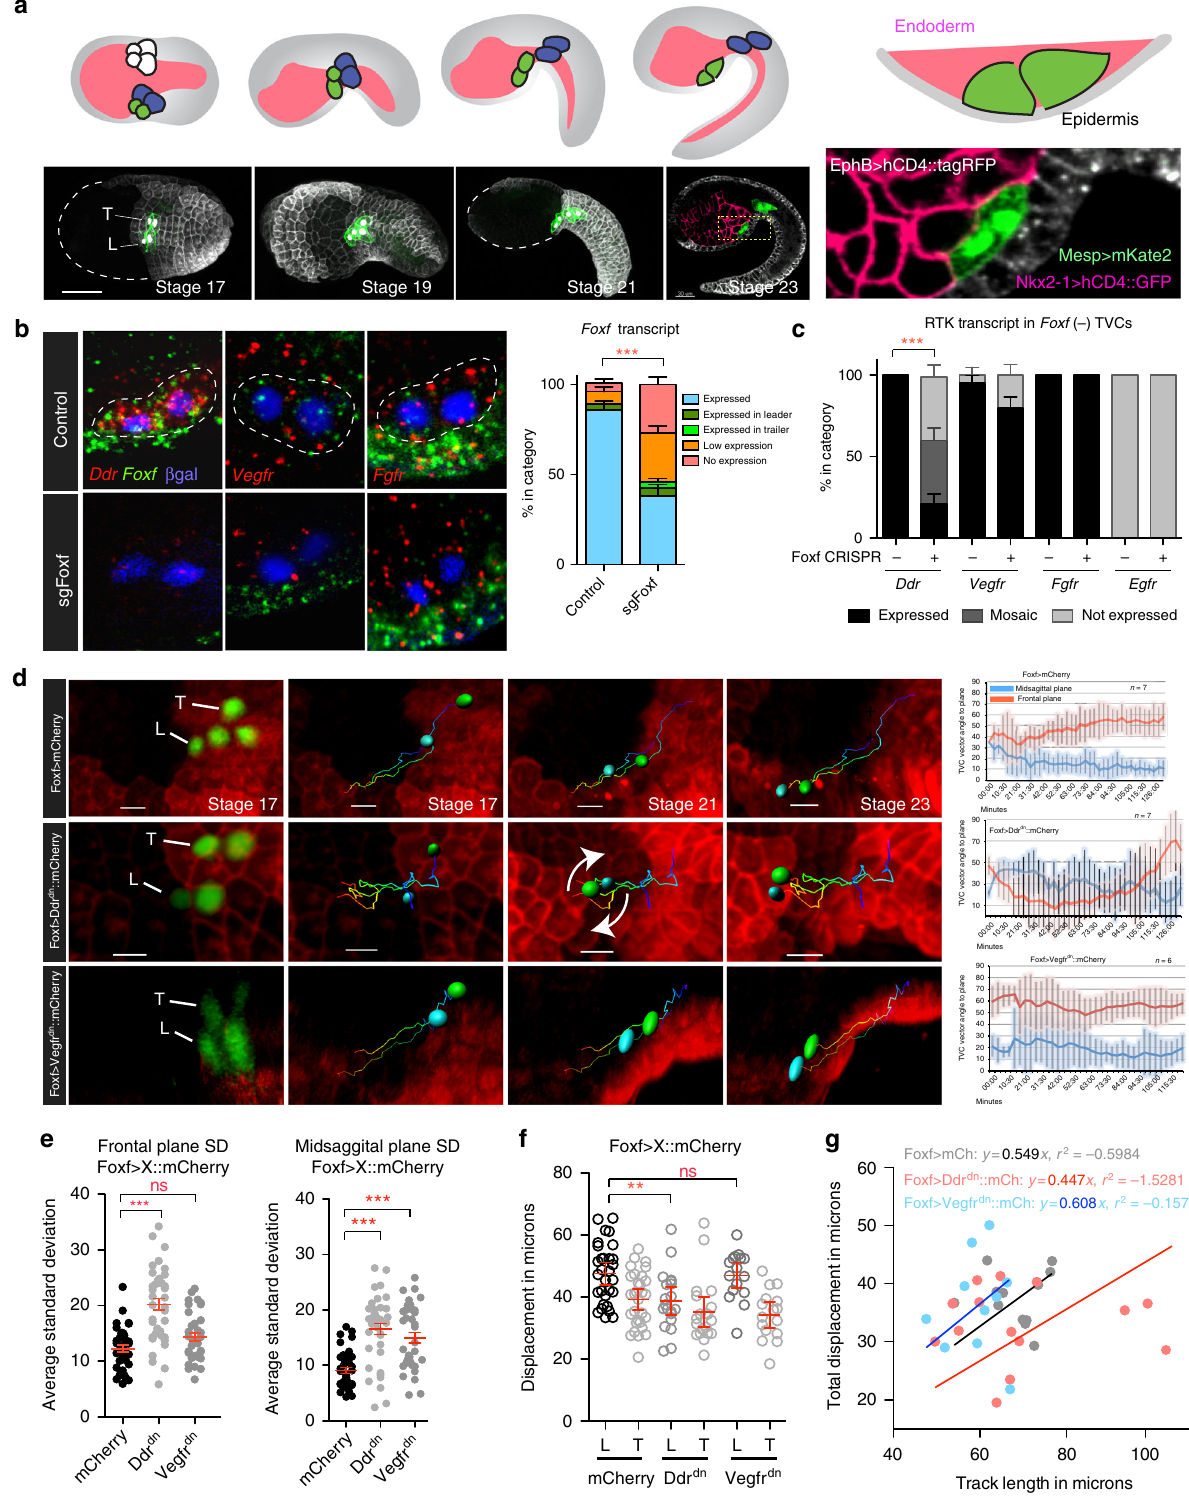
quantify the variability of cell positions by calculating the stan- dard deviation of the angles between leader-trailer axes and the sagittal and frontal planes at each time point (Fig. 1d), assuming that migrating cells that are constrained during their movement will have a narrow SD pro fi le. We used cell division times to align